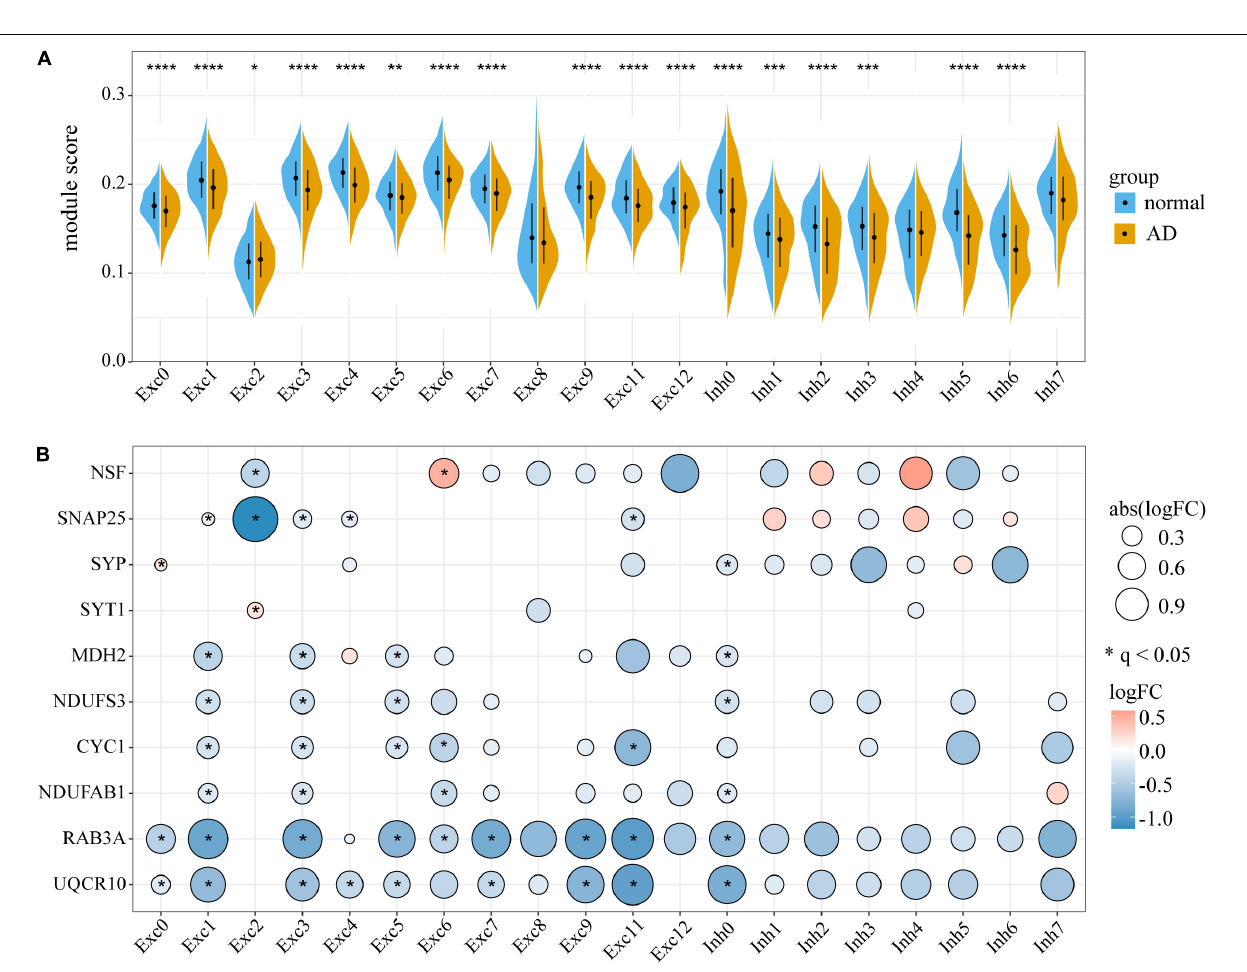
FIGURE 4 | Expression change of M3 and M8 in AD at single-cell resolution. (A) Comparison of gene expression scores of M3 and M8 between AD cases and controls in different neuronal subtypes of the prefrontal cortex (PFC). Mann-Whitney test with Benjamini-Hochberg correction was used to determine statistical significance. The black circle and bar indicate median and quartiles (25th and 75th percentile), respectively. * q < 0.05, ** q < 0.01, *** q < 0.001, **** q < 0.0001. (B) Differential expression analysis of hub genes between AD patients and controls in different neuronal subtypes. Blue and red colors indicate downregulation and upregulation respectively. Only genes with absolute LogFC > 0.14 are shown. * q < 0.05. Exc, excitatory neuron; Inh, inhibitory